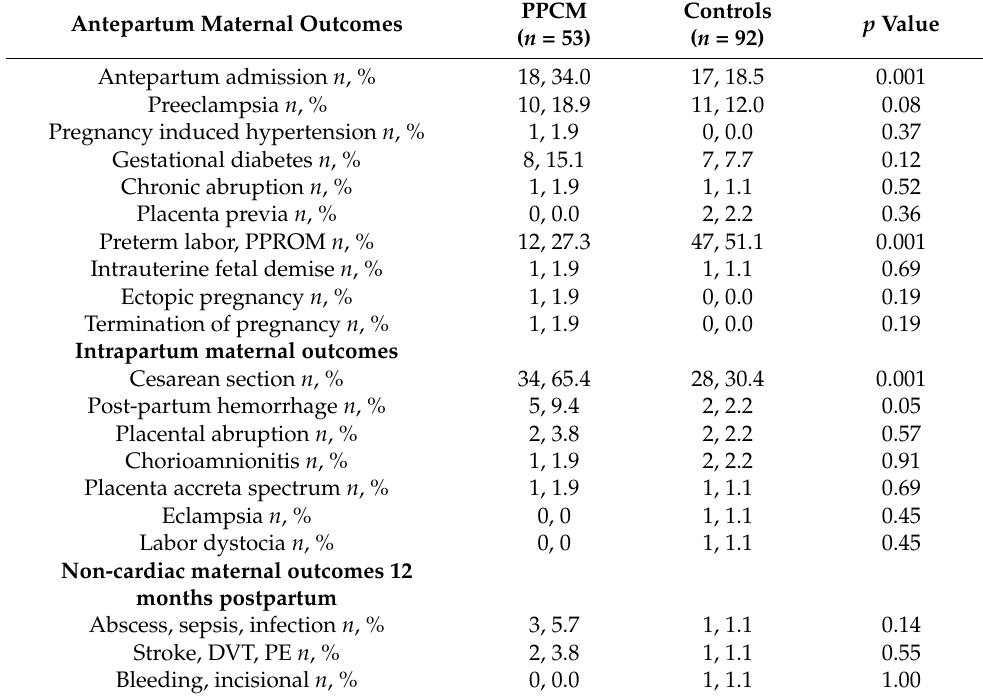
Table 5. Antepartum, intrapartum, and non-cardiac 12 month outcomes in women with PPCM ( n = 53) vs. controls ( n =